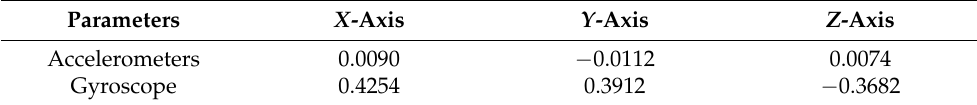
Table 5. Zero bias of MEMS0 accelerometers and gyroscopes.